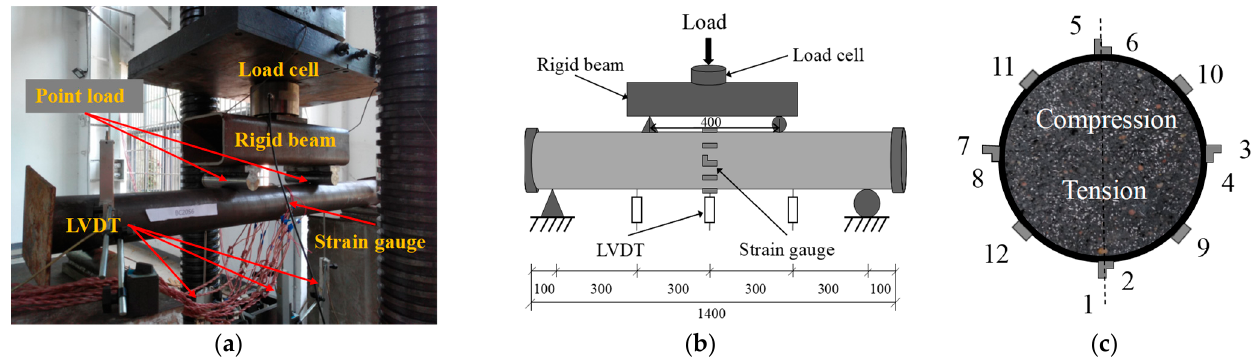
Figure 3. Experimental setup and locations of strain gauges. ( a ) Experimental setup; ( b ) schematic diagram (Unit: mm); ( c ) strain gauge locations.